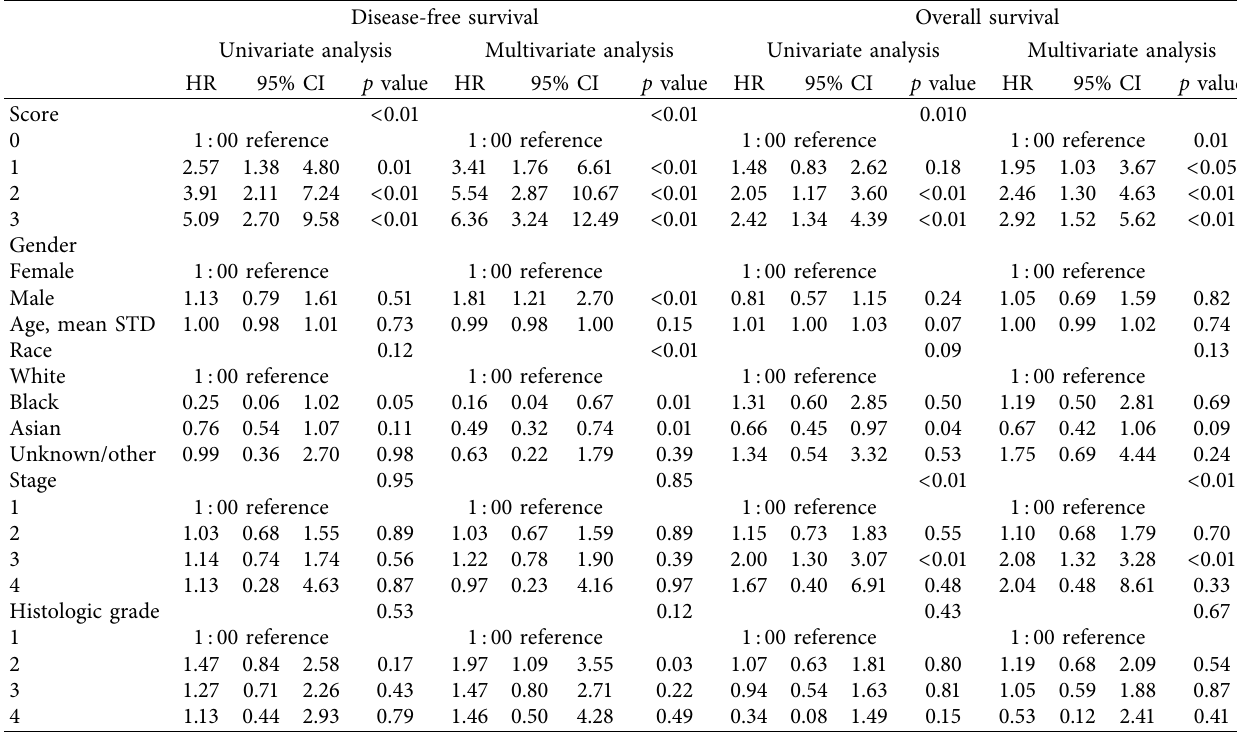
Table 2: Cox regression: DFS and